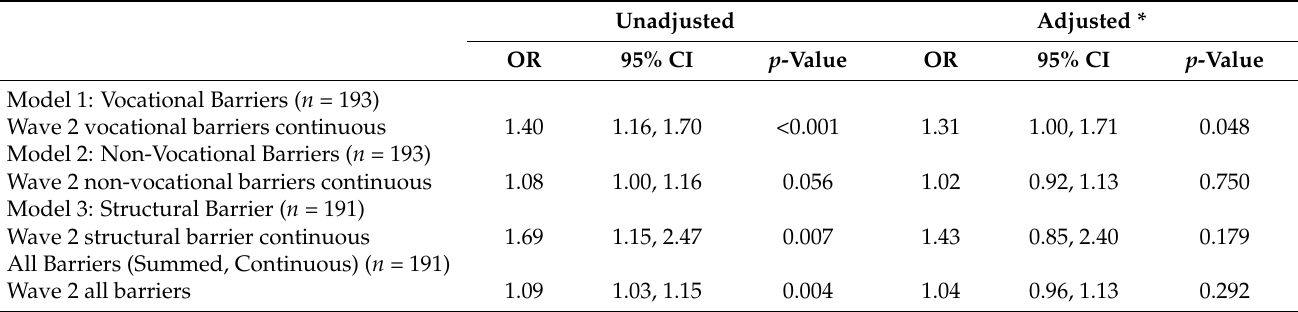
Table 5. Unadjusted and adjusted logistic regression analysis, Wave 2 barriers association with Wave 2 employment status.